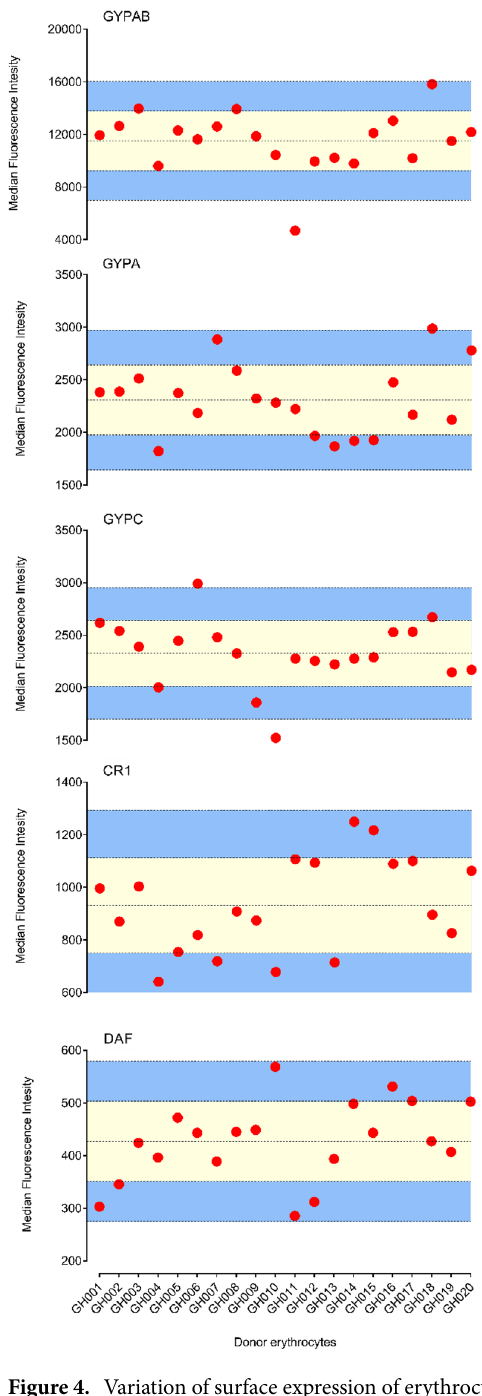
Figure 4. Variation of surface expression of erythrocyte receptors between donors. Dot plots of relative median fluorescent intensity (Y-axis) associated with fluorescently labelled antibodies against specific erythrocyte receptors (GYPAB, GYPA, GYPC, CR1 and DAF) from 20 blood donors (X-axis). Data were acquired by a BD LSR Fortessa X-20 flow cytometer and processed with FlowJo v.10.01. The data were stratified following normalization and donors were classified as high (Mean + 2SD, upper line), medium (between Mean ± SD, yellow area) and low expressers (Mean-2SD, bottom line). Graphs were plotted using GraphPad Prism v.8.01. MFIMean Data normalization was performed as follow MFIs as follow CorrMFIS = MFIS ∗ MFIC , where ‘‘CorrMFI’’ is the corrected mean fluorescence intensity of a given donor, ‘‘MFIS’’ is the uncorrected mean fluorescence intensity of the sample, ‘‘MFICMean’’ is the mean mean fluorescence intensity of all the control samples, and ‘‘MFIC’’ is the mean fluorescence intensity of the control for that